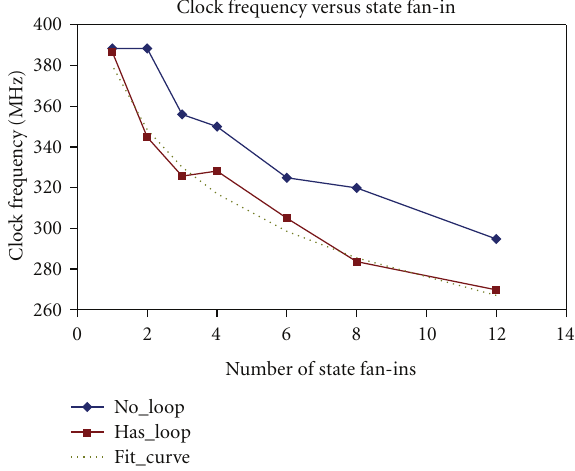
Figure 13: Clock frequency versus state fan-in of the synthetic